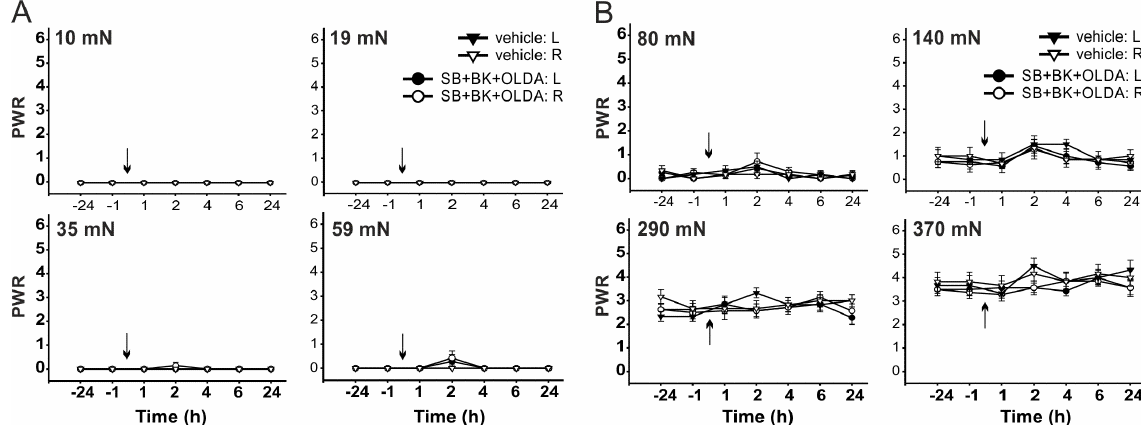
Figure 6. Intrathecal TRPV1 antagonist pretreatment prevented BK- and OLDA-induced mechanical hypersensitivity. Administration of SB366791 (0.58 µg, i.t., n = 7), 15 min prior to co-administration of BK and OLDA, completely blocked mechanical allodynia examined with the von Frey filaments, with bending forces ranging from 10 mN to 59 mN ( A ), and hyperalgesia tested with forces from 80 mN to 370 mN ( B ). Data represent the mean ± S.E.M. of 7 (SB + BK + OLDA) and 6 (vehicle) independent experiments. The time of the i.t. administration is marked by arrows.